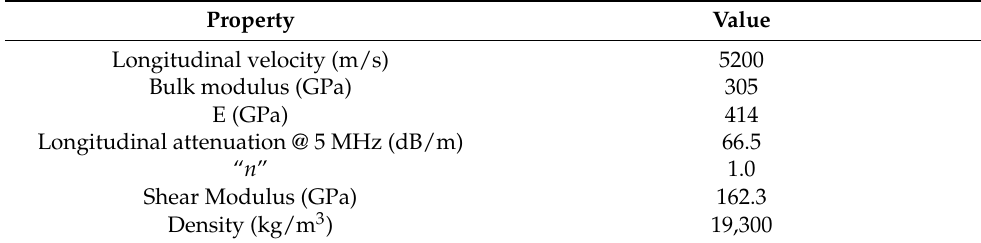
Table 4. Properties of the Tungsten